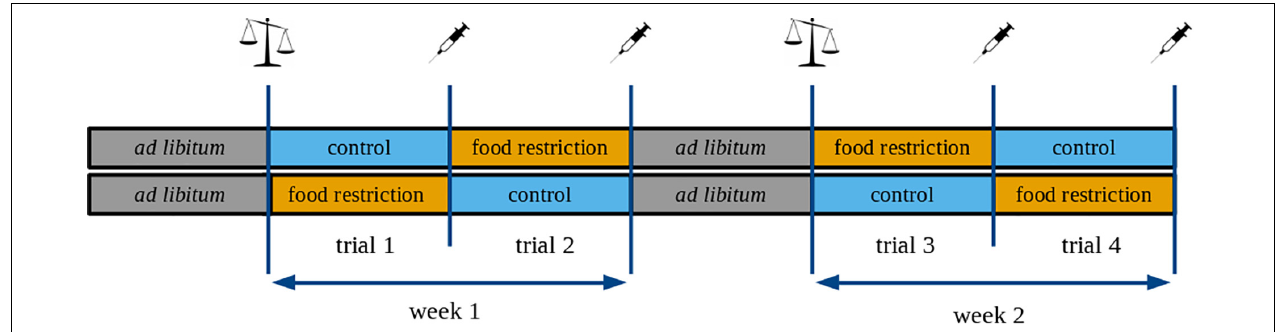
FIGURE 1 | Schematic illustration of the experimental design. Every treatment lasted for three consecutive days, and we called these periods “trials”. Every bird received the control and the food-restricted treatment twice. We refer to the first replicate as “week 1” and to the second replicate as “week 2”. The syringe icon denotes blood sampling and body mass measurements, whereas the balance icon indicates only body mass measurements.